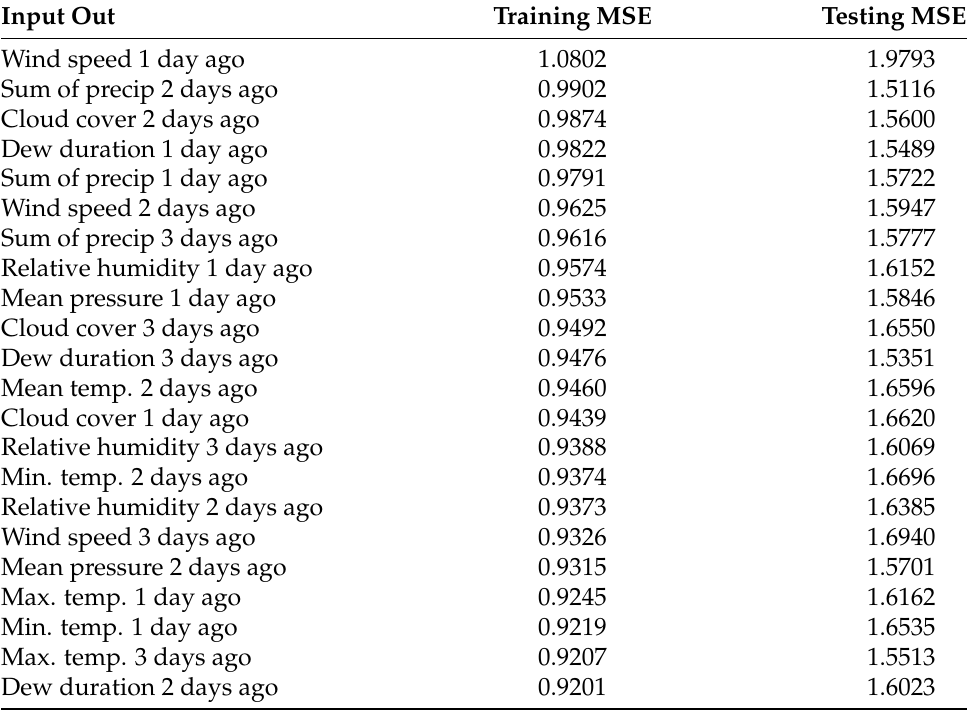
Table A5. The results of the sensitivity analysis for the prediction of the mean daily wind